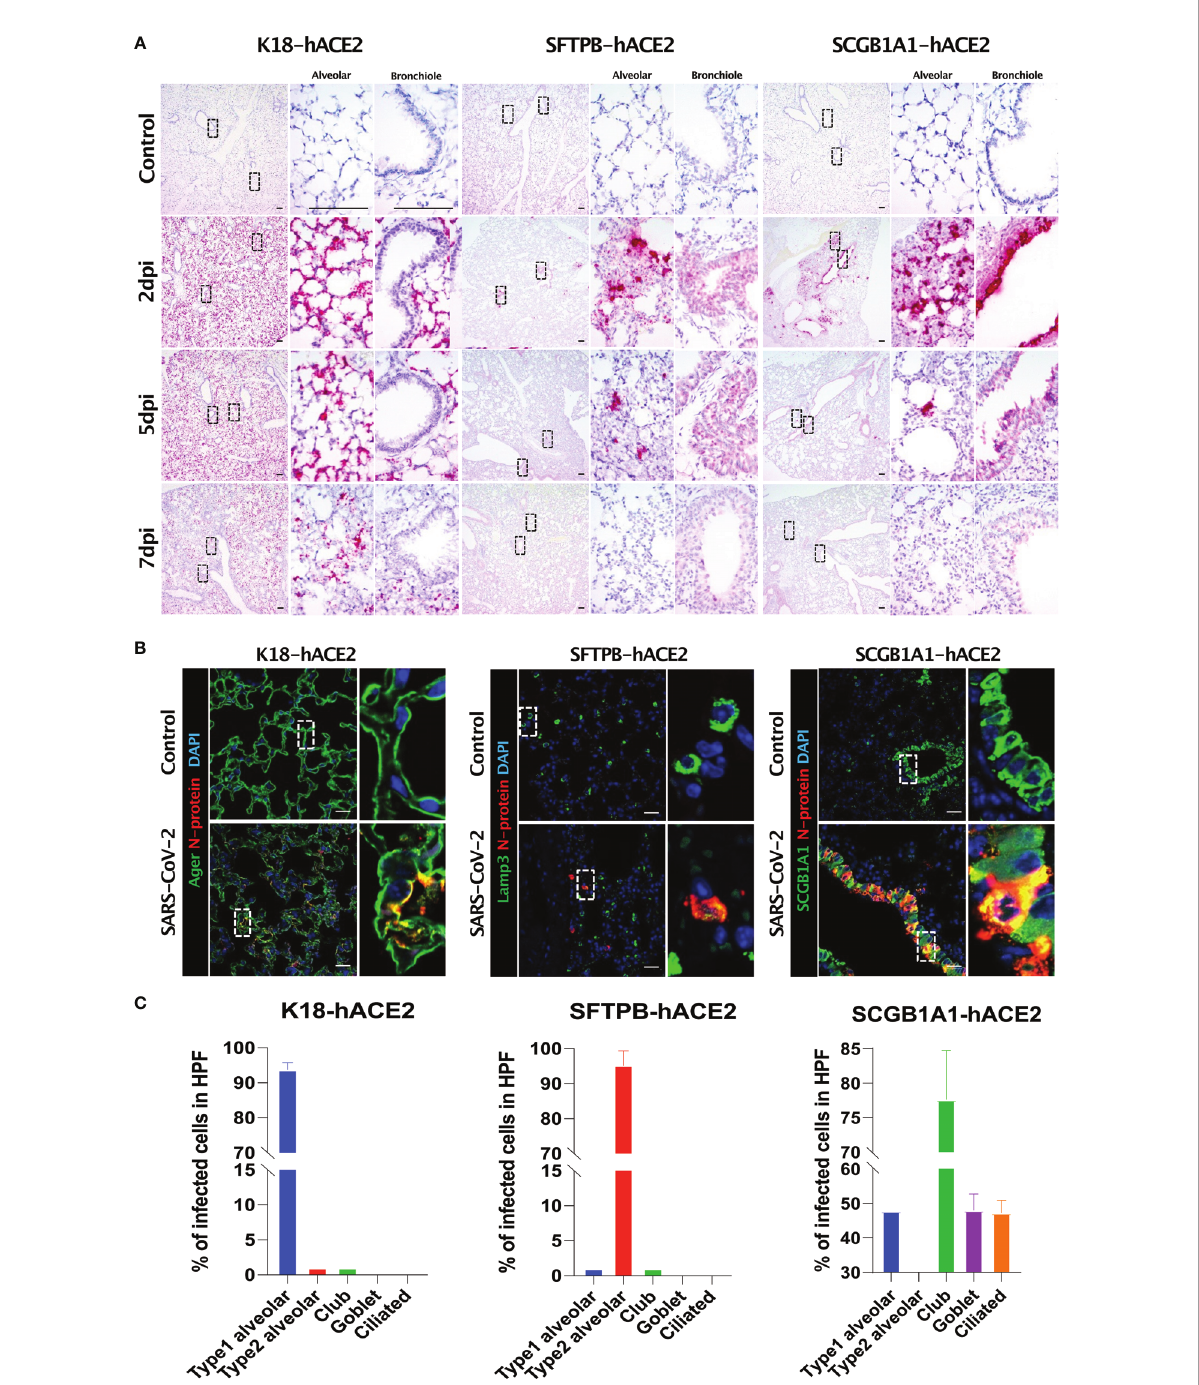
FIGURE 4 SARS-CoV-2 distribution and viral target cells in the lungs from each mouse model. (A) SARS-CoV-2 distribution in the lungs analysed using in situ hybridisation at 2, 5, and 7 dpi with 1 × 10 5 PFU SARS-CoV-2. (B) Representative confocal immuno fl uorescence micrographs of the lungs of K18-hACE2 (left), SFTPB-hACE2 (middle), and SCGB1A1-hACE2 (right) mice from the PBS-treated control group (top) and SARS-CoV-2-infected group (bottom) at 2 dpi. SARS-CoV-2 N-protein-positive cells are stained red, and type 1 alveolar (Ager), type 2 alveolar (Lamp3), or club (SCGB1A1) cells are stained green. Nuclei of cells are stained blue with DAPI. The scale bars are 100 m m. (C) Quanti fi cation of the percentage of infected cells from the lungs of K18-hACE2 (left), SFTPB-hACE2 (middle), and SCGB1A1-hACE2 (right) mice analysed from the confocal immuno fl uorescence micrographs shown in (B) . Lung sections from SARS-CoV-2-infected mice at 2 dpi stained with anti-SARS-CoV-2 N- protein antibody and one of anti-Ager, anti-Lamp3, anti-SCGB1A1, anti-Muc5ac, or anti-tubulin